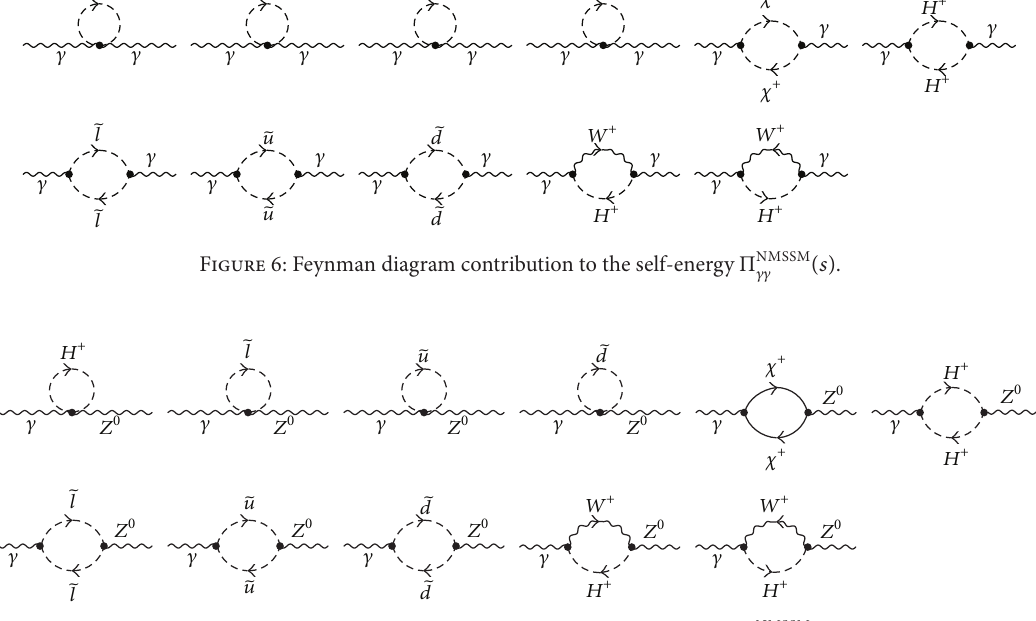
Figure 7: Feynman diagram contribution to the self-energy Π NMSSM 𝑍𝛾 (𝑠)